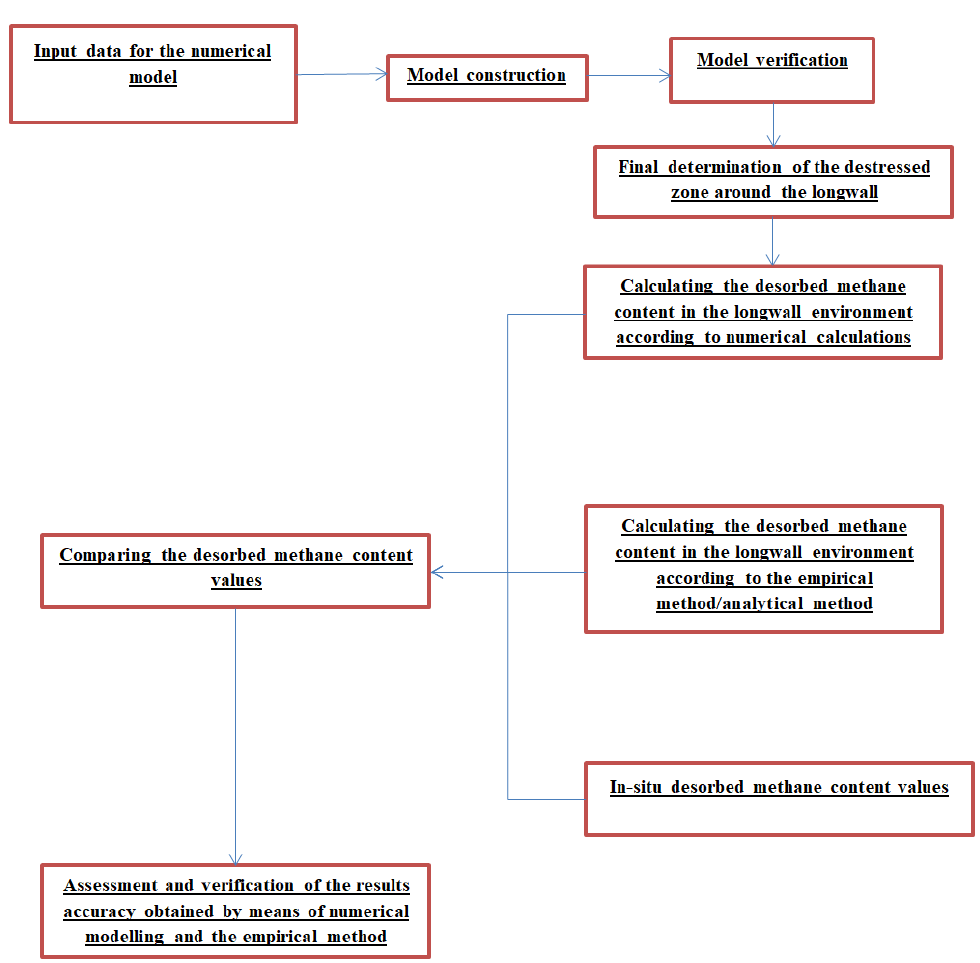
Figure 4. Algorithm for absolute methane emission rate forecasting in the area of a longwall caving extraction.